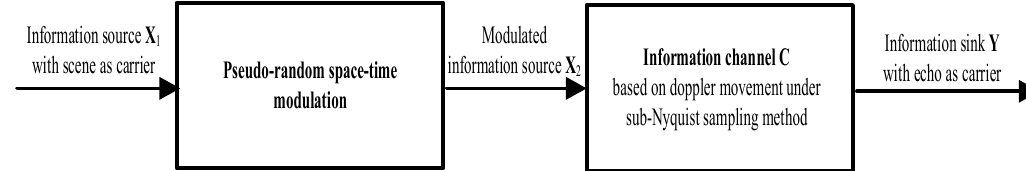
Figure 4. The information channel after pseudo-random space-time modulation. Information channel is based on Doppler movement under the sub-Nyquist sampling method. After pseudo-random space-time modulation, the mutual information between information source X 1 and information sink Y is increased so that the scene with large value of sparsity is reconstructed.